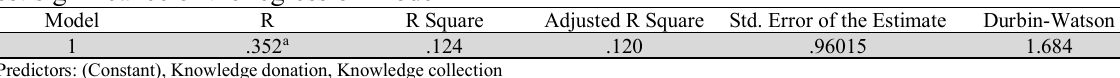
Test significance of the regression